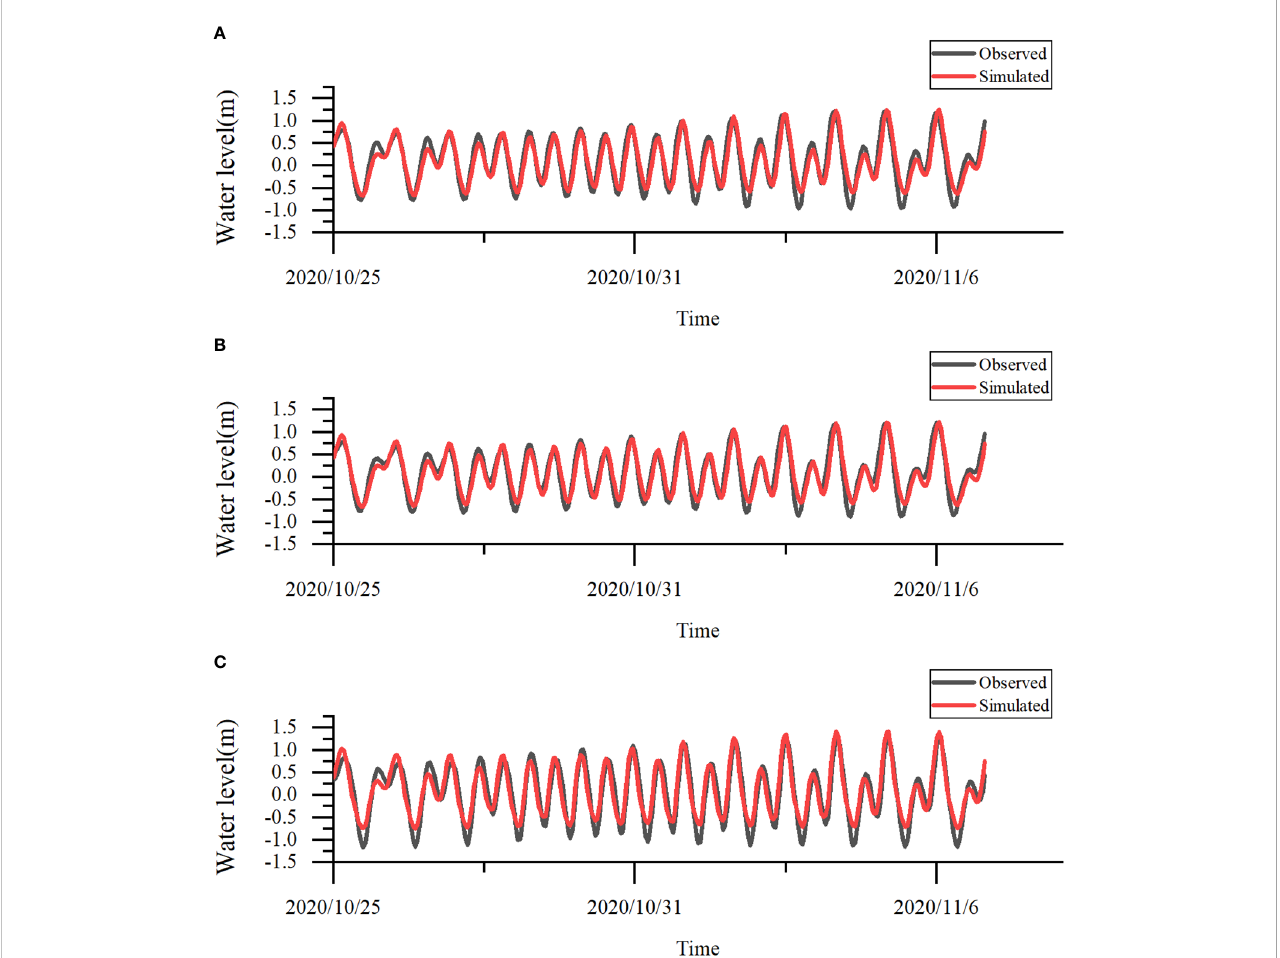
FIGURE 4 Water level validation at (A) Shanban Island; (B) Neilingding Island; and (C)